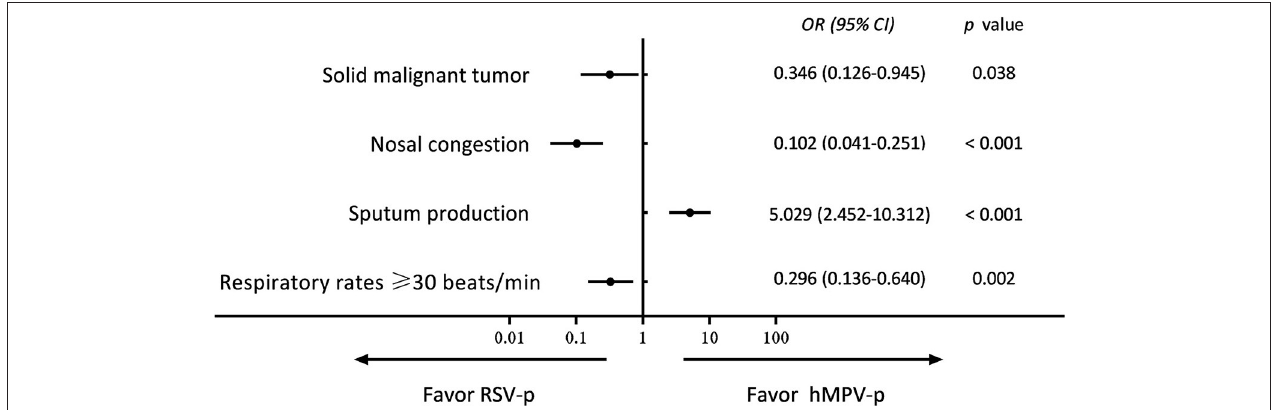
FIGURE 2 | Multivariate analysis of predictors for hMPV-p (compared with RSV-p).